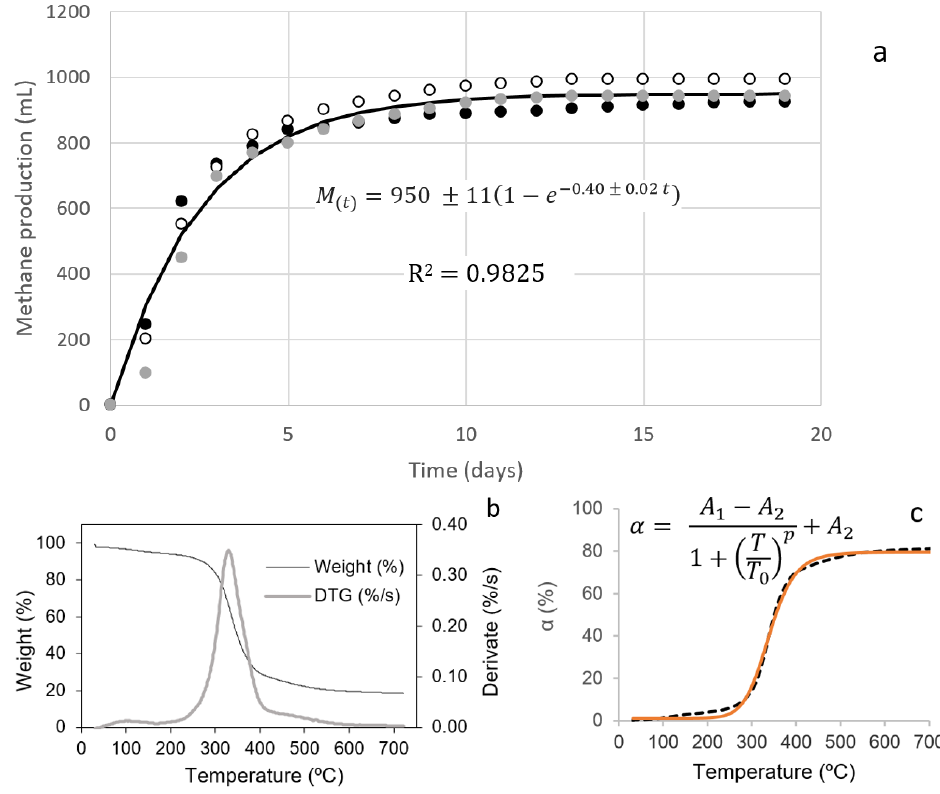
Figure 1. ( a ) Cumulative methane production curves derived from batch assays evaluating BMP of fourth-range products. ( b ) TG and DTG profiles of the fourth-range waste sample. ( c ) Alpha curve and curve-fitted data. Table 4. Results reported in the literature regarding methane yields obtained from food wastes under different operating